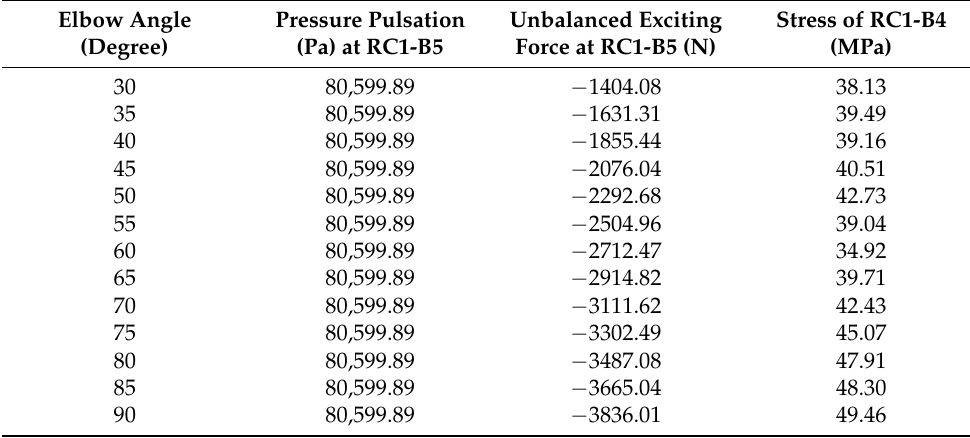
Table 7. Pipe stress under different support spacing.